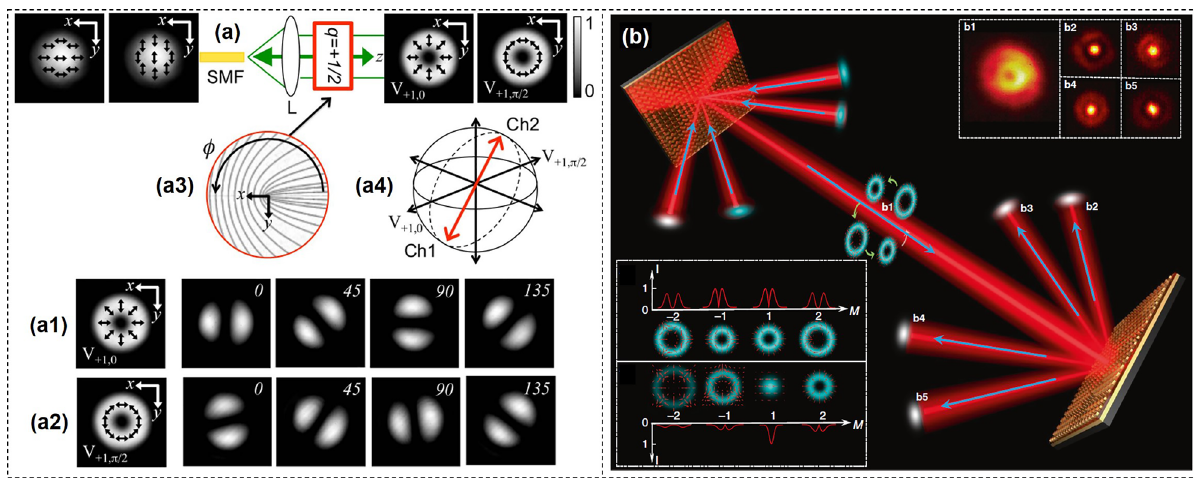
Figure 22: Vector beams multiplexing communications. (a) Transformation of the state of polarization of the fundamental mode of an SMF into a linear combination of vector modes using a liquid crystal q-plate as described in the text: q = 1/2 plate [127]. (b) Schematic of vector beams multiplexing/demultiplexing by using metasurface- based Dammann optical vector gratings [128]. Reprint permission obtained from [127, 128].